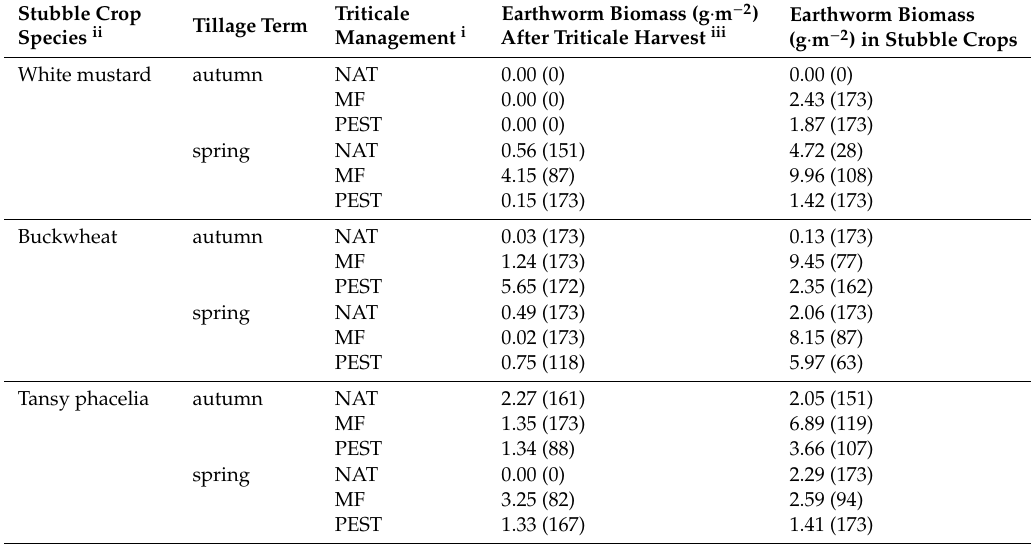
Table 2. The changes in earthworm presence as a fresh biomass parameter (g · m − 2 ) within 10 weeks in various